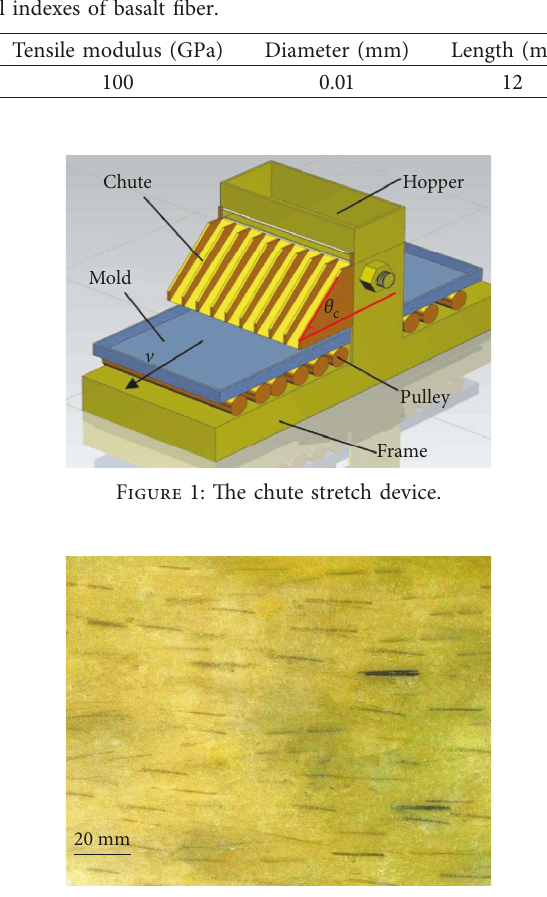
Figure 2: Molding effect of oriented basalt fiber/epoxy composite � material ( V f